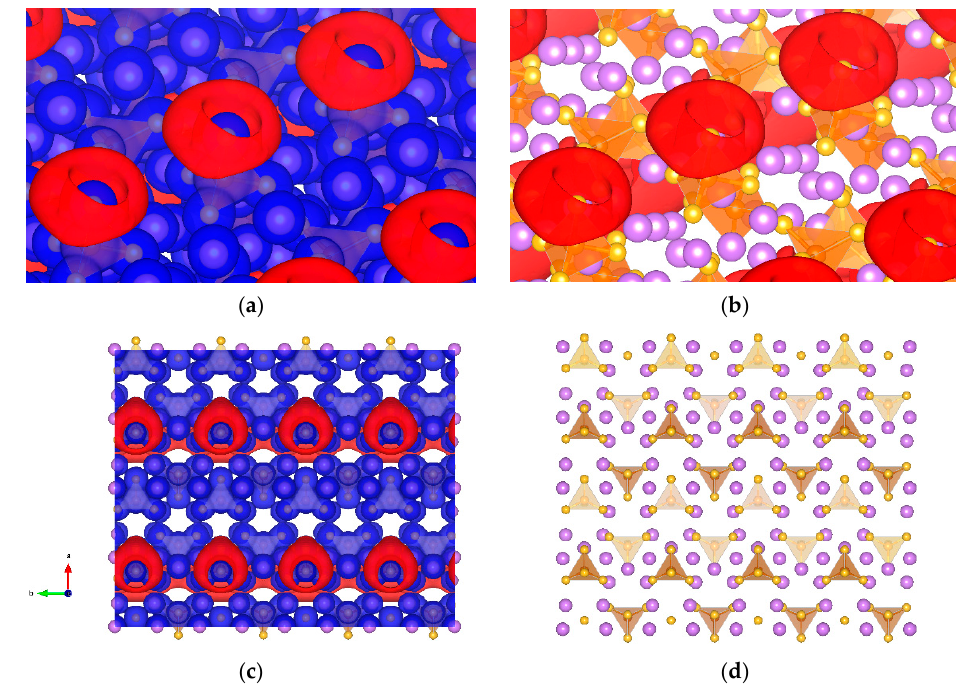
Figure 10. Li 3 PS 4 studied as a crystal on (001) surface ( a ) Isopotential ±3.1 V surface of Li 3 PS 4 separated between negative (red) and positive (blue) regions; ( b ) Li 3 PS 4 atomic conformation and isopotential − 3.1 V; ( c ) top view of the crystal of Li 3 PS 4 and isopotential ±3.1 V; and ( d ) top view of the crystal of Li 3 PS 4 . Solid purple spheres represent lithium, yellow for sulfur, and orange represents PS 4 tetrahedron.